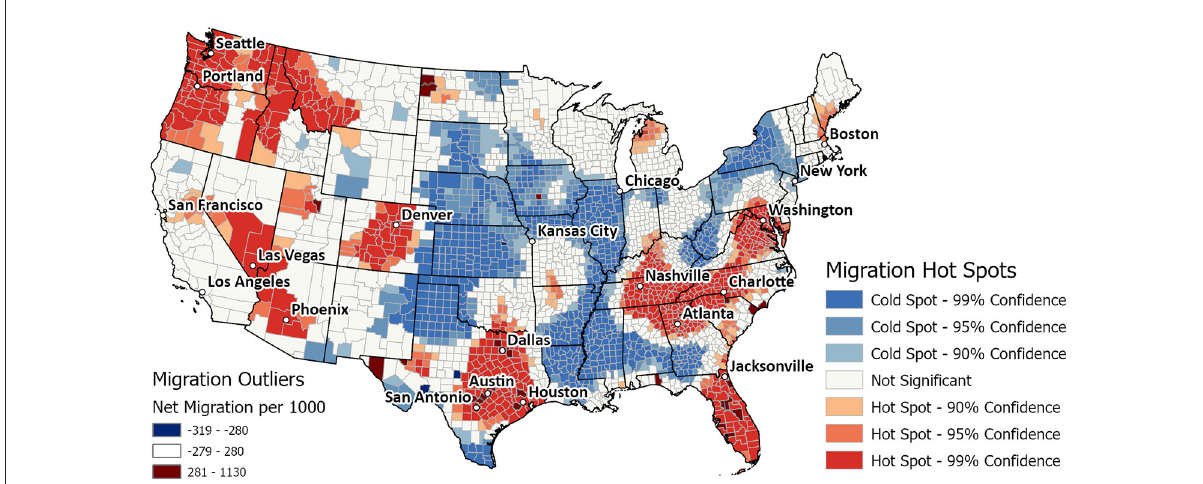
FIGURE1 Results of a Getis-Ord Gi* hotspot analysis of county-level net migration rates, 2010–2020. Migration hot spots, where many more people moved into a region than out, are in shades of red. Migration cold spots, where many more people left than arrived, are in shades of blue. Statistical outliers in the net migration data (values lying more than three interquartile distances beyond the interquartile range) were excluded from the analysis, but are shown in the darkest shades of red and